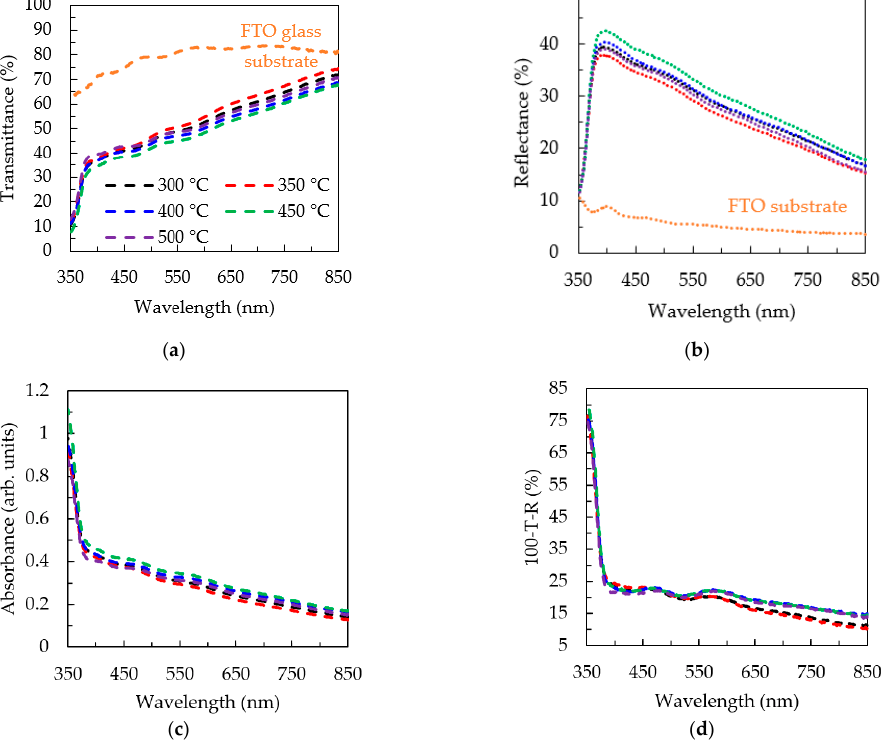
Figure 4. The ( a ) transmittance, ( b ) reflectance, ( c ) absorbance, and ( d ) the haze spectra for the 7.5 wt%-injected TiO 2 film annealed at different temperatures from 300 to 500 °C.